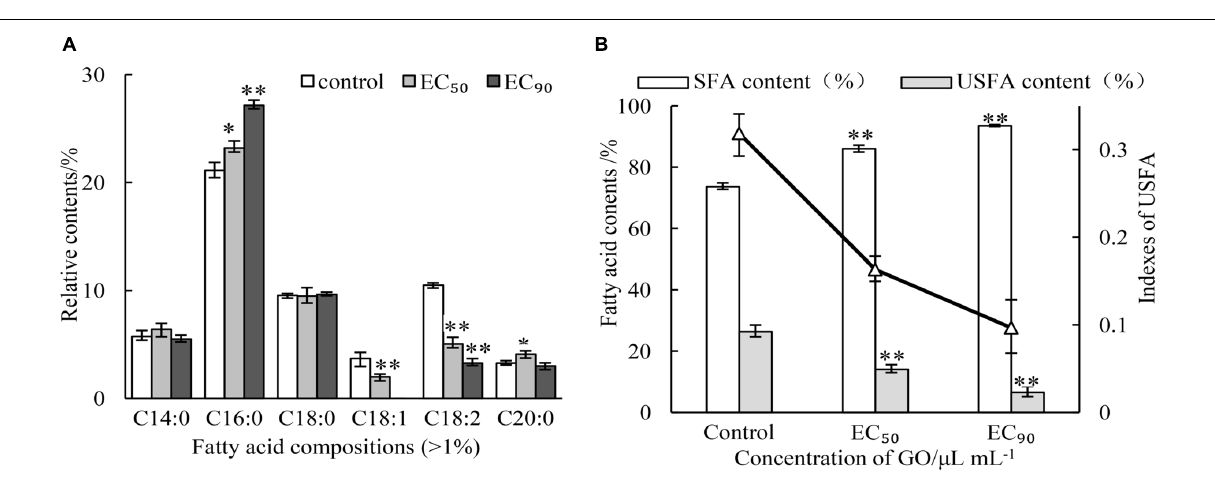
distorted, intertwined and crimpled ( Figure 2E ), which caused irregular constriction even disruption ( Figure 2F ). Therefore, the evidence from SEM observation indicated that the treatments with GO caused distortion, sunken and serious damage to the morphology of the mycelial and effectively inhibited its